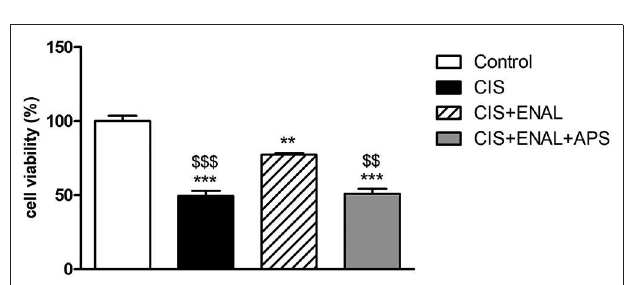
FIGURE 6 | Cell viability assay in mouse epithelial tubular cells. The panels show cell viability assay in mouse tubular cells after treatment with cisplatin, enalaprilat and apstatin. Data presented as Mean ± SEM; ** p < 0.01, *** p < 0.001 compared to the control group. $$ p < 0.01 $$$ p < 0.001 compared to the CIS + ENAL